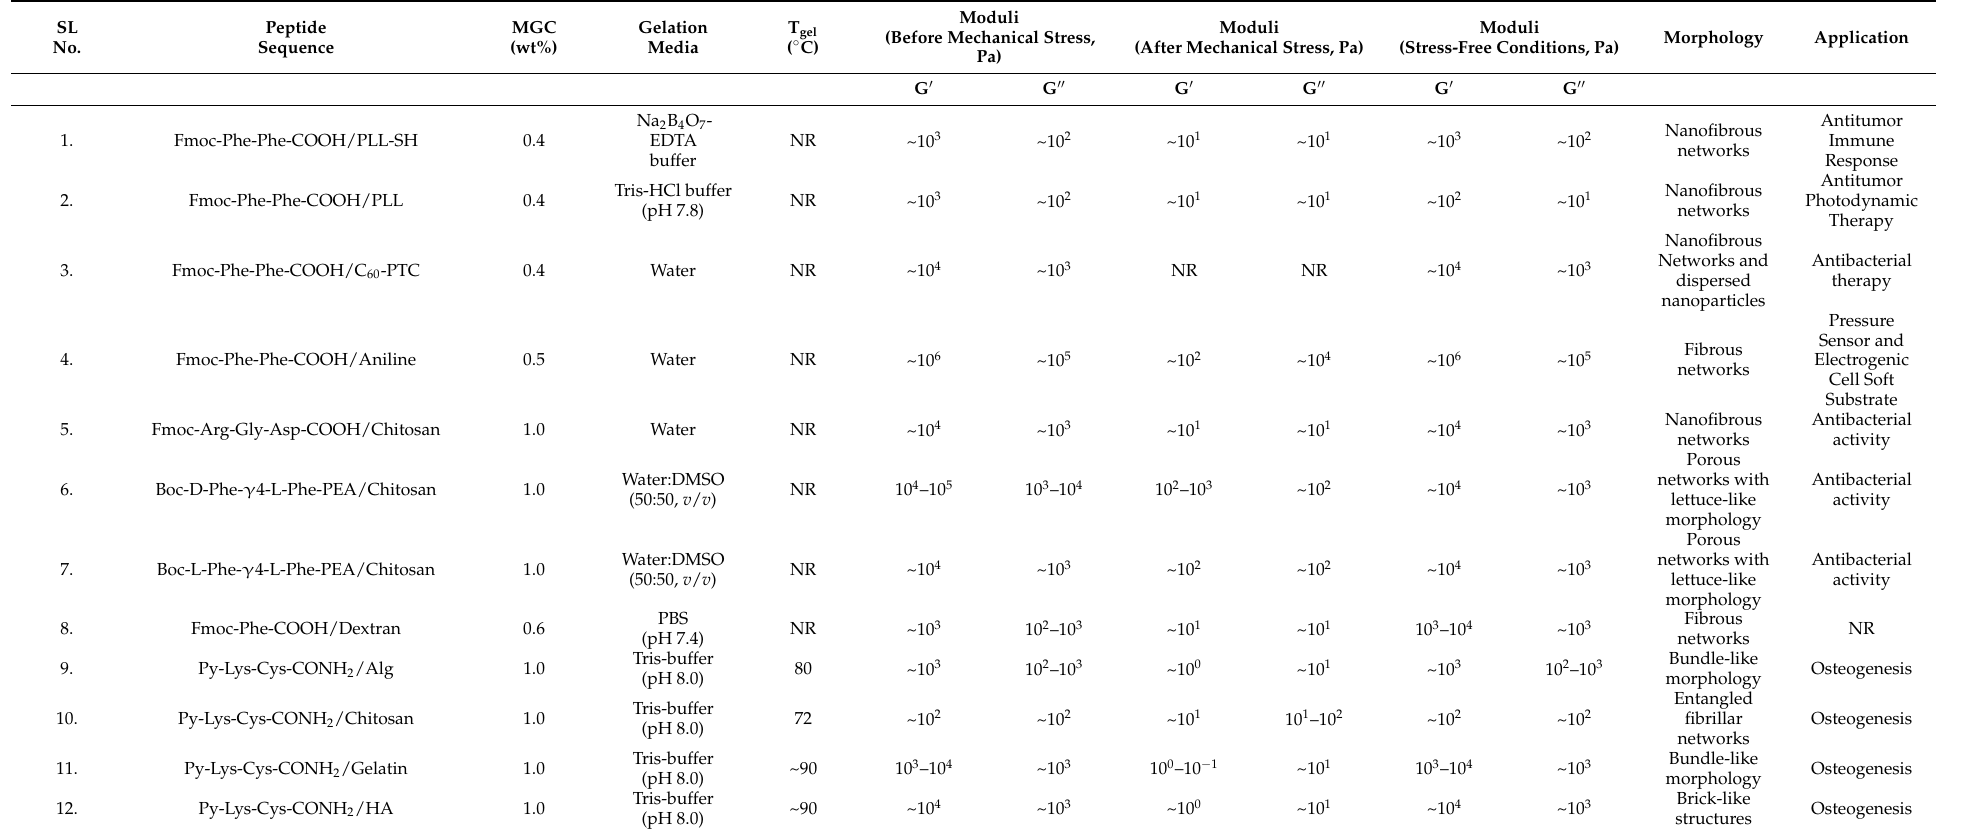
Table 7. List of composite hydrogelators and respective gelation